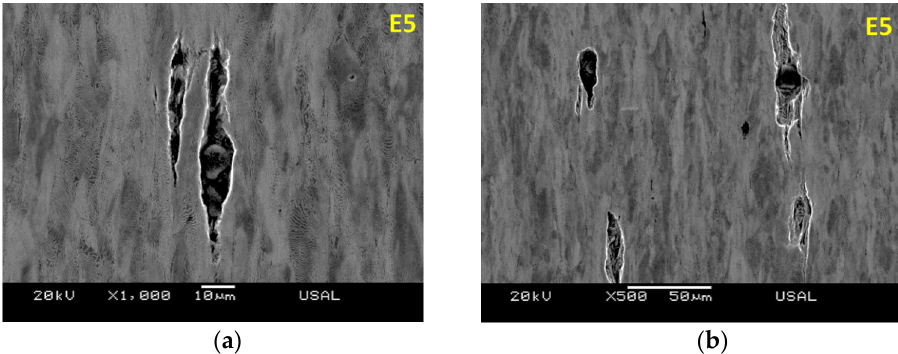
Figure 10. Inclusions in moderately drawn steel E5 (five drawing steps) at 1000x ( a ) and 500x ( b ).